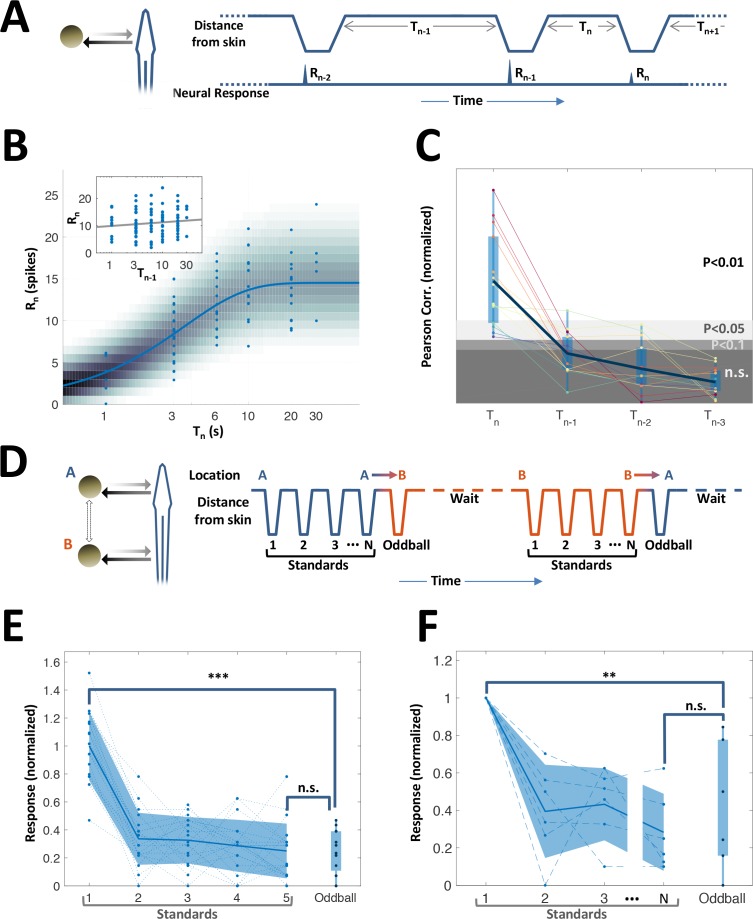
History-independent, spatially non-specific adaptation of PG cells.(A) Random interval protocol. Object motions toward- and away-from-skin generated responses Rn, measured by spike count within individually determined time-window. Motions were interleaved by random time intervals Tn (1–30 s). (B) Response versus the preceding time-interval (log scale) for an example neuron (circles). Model fitted to the data-points is depicted by response rate (solid blue line) and spike count distribution (background shading); correlation of data to model = 0.56 (p < 10−6, random permutations). Inset: same data-points plotted as function of penultimate intervals; grey line: linear regression to log(T) (correlation = 0.15, p = 0.136, random permutations). (C) Correlations between responses and time-intervals (last interval and one-, two- or three-before-last), normalized to the 10, 5 and 1 top percentiles of correlations generated by random permutations of the data, for each of the 15 adapting cells tested (thin colored lines; thick blue line: mean across population). For most cells, the response was significantly correlated only with the last interval. (D) Spatial oddball protocol. A sequence of N standard stimuli at one location (N = 5–9) was followed by one oddball stimulus at a different location. (E) Response of example cell (normalized to non-adapted response) to oddball protocol (dotted lines: individual tirals, N = 10; thick line and shaded area: mean ± standard deviation). Response to the oddball was significantly weaker than the non-adapted response (p < 10−4, bootstrap) and not significantly different from the response to the last standard stimulus (p = 0.45, bootstrap). (F) Normalized response of all adapting cells tested with the spatial oddball protocol (dashed lines: individual cells, N = 6; thick line and shaded area: mean ± standard deviation). Population response to the oddball was significantly weaker than the non-adapted response (p = 0.001, bootstrap) and not significantly different from response to the last standard stimulus (p = 0.2, bootstrap). ‘**’, p < 0.01; ‘***’, p < 0.001; n.s., not significant.